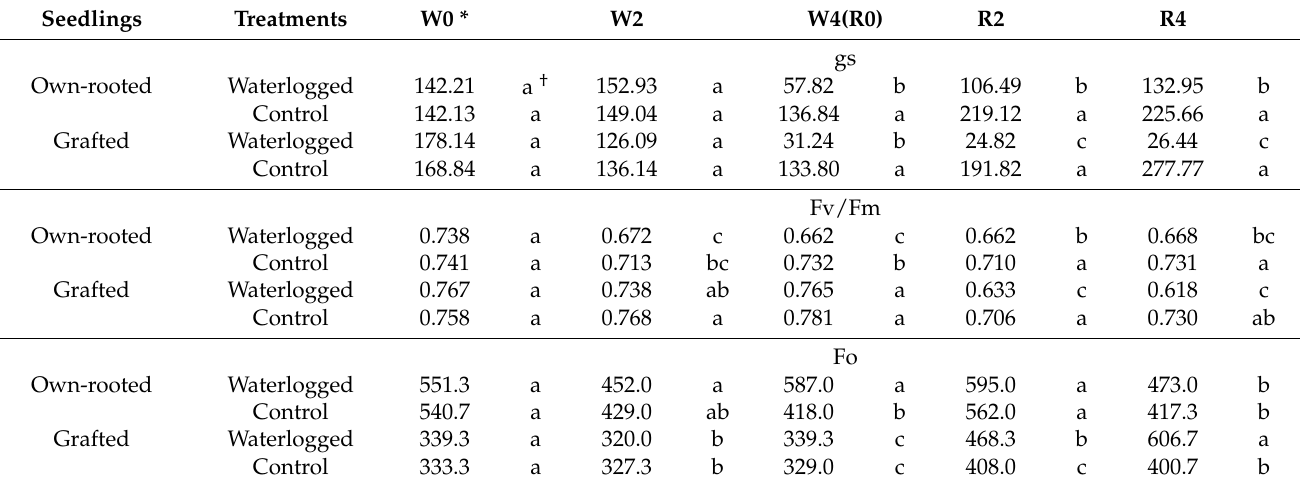
Table 1. Stomatal conductance (gs), Fv/Fm, and Fo of avocado cultivar ‘Black-Beauty’ during 4-day waterlogging and 4-day post-waterlogging periods.